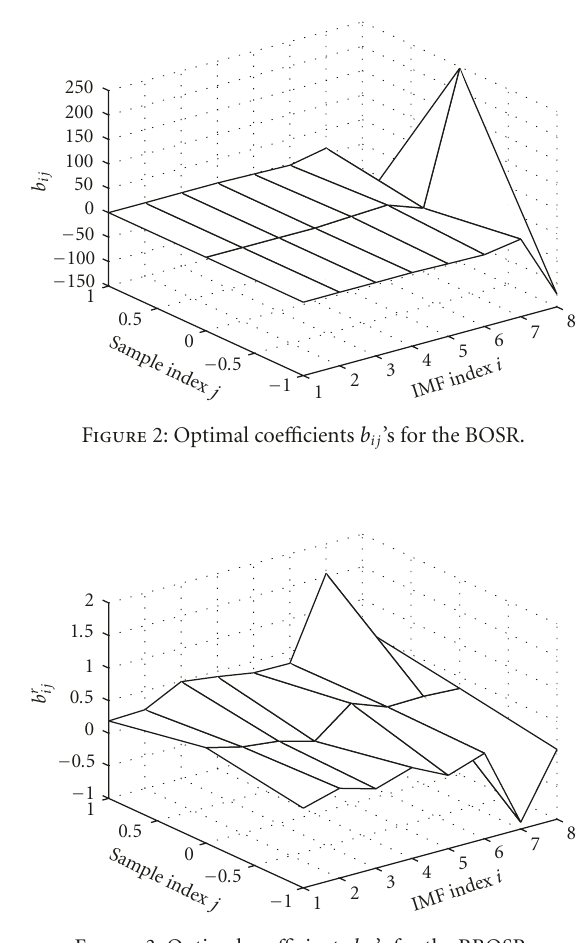
Figure 3: Optimal coe ffi cients b ij ’s for the